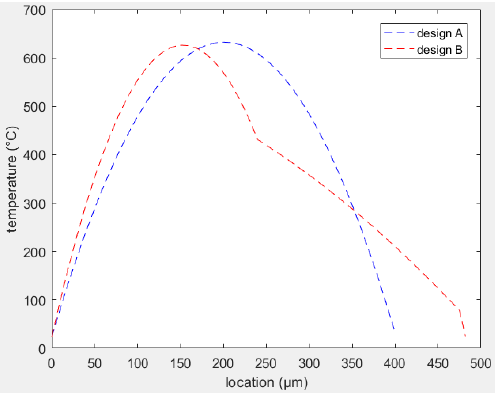
Figure 9. Comparison between temperature profiles in designs A and B.